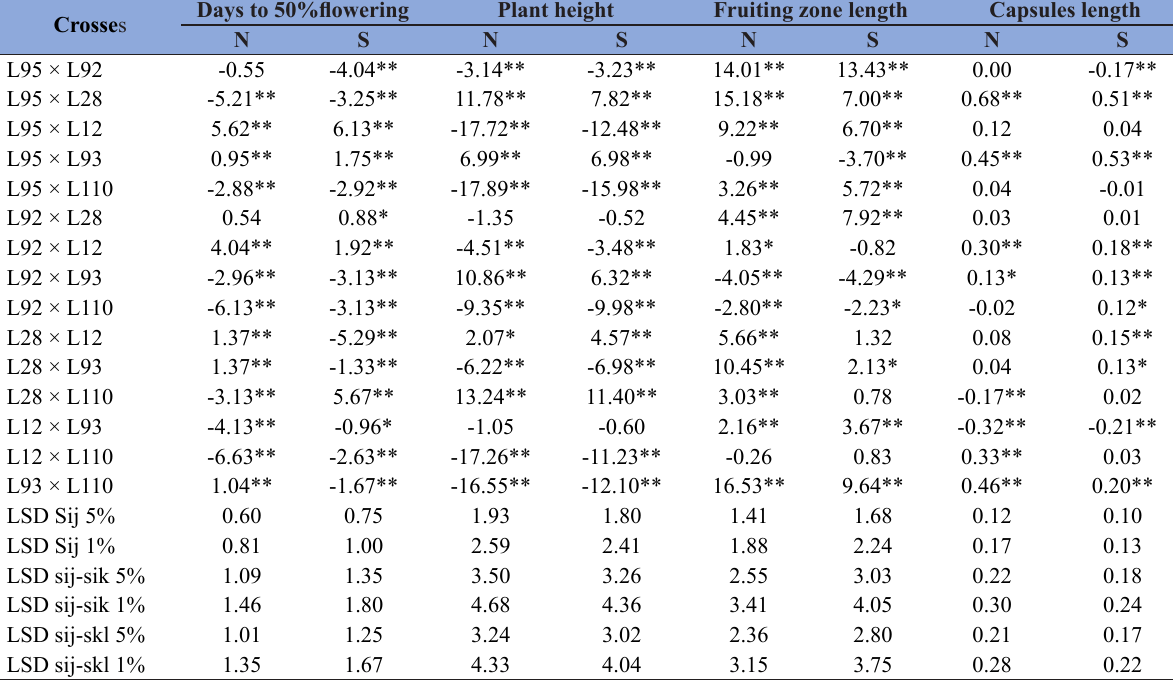
cross combinations for days to 50% flowering, plant height, fruiting zone length Table 9a . Specific combining ability effects of 15 F 1 and capsules length under normal irrigation (N) and water stress conditions (S) in 2019